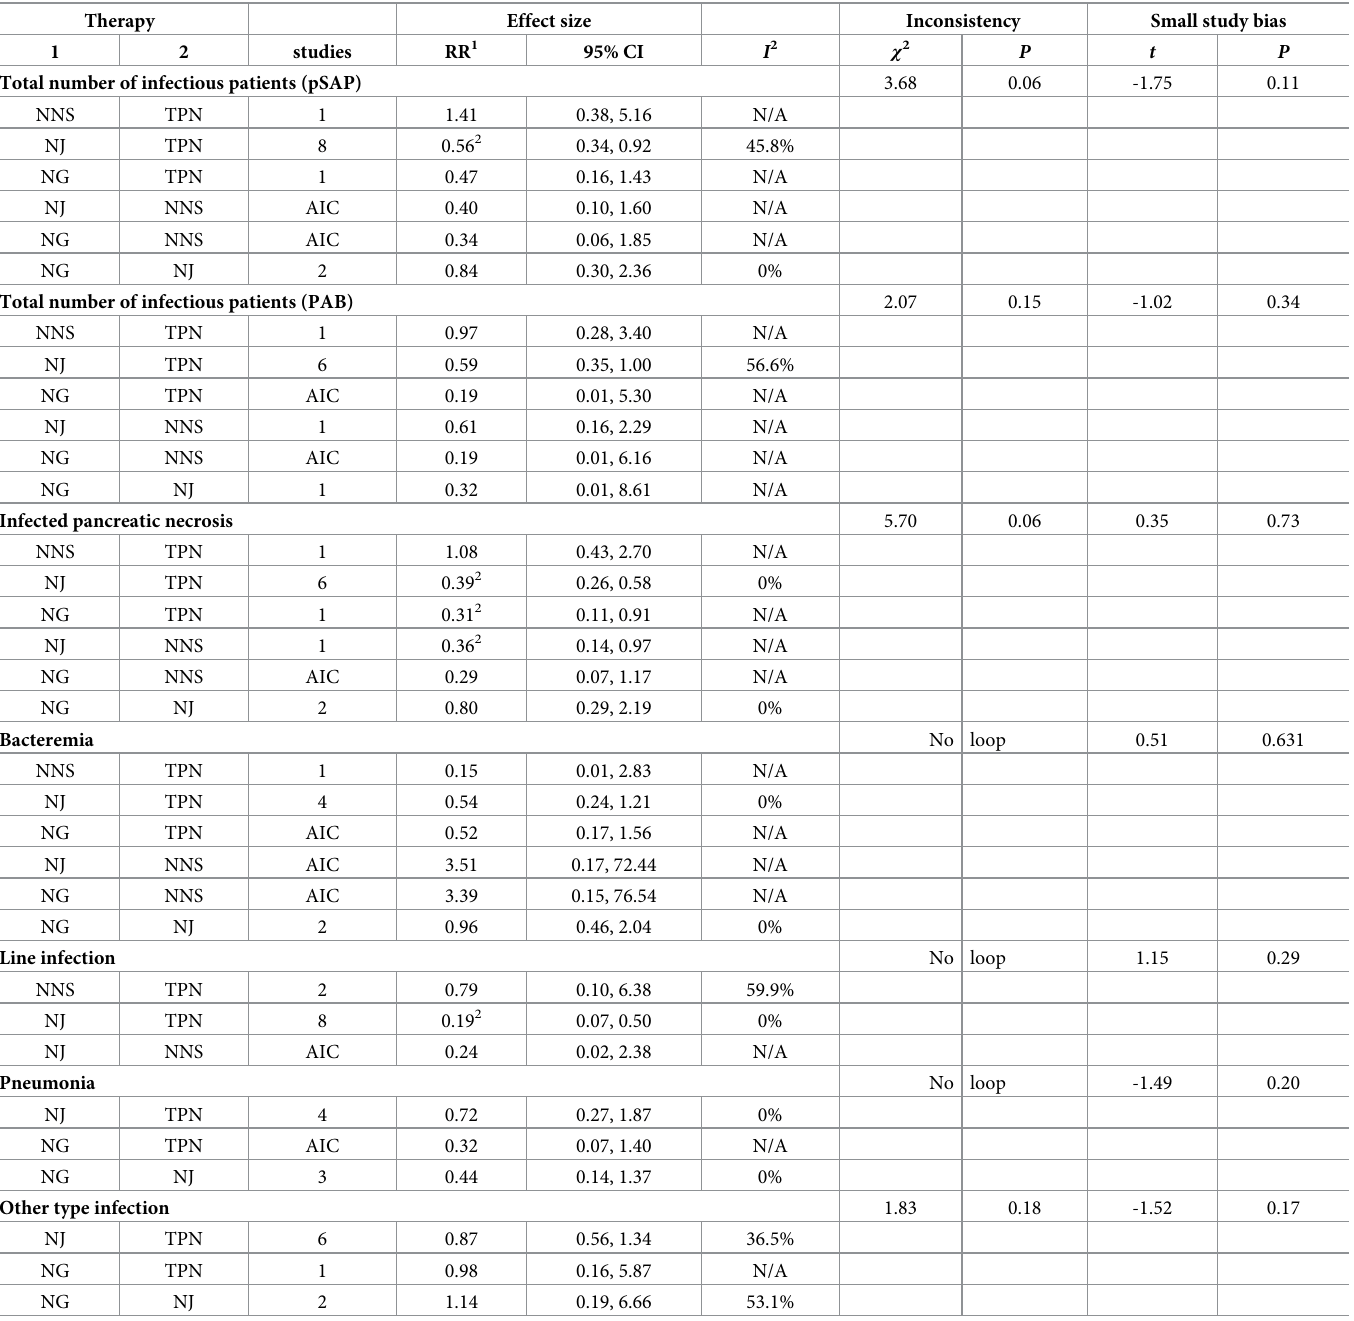
Table 2. Summary of further network meta-analysis for total number of infectious patients. Therapy Effect